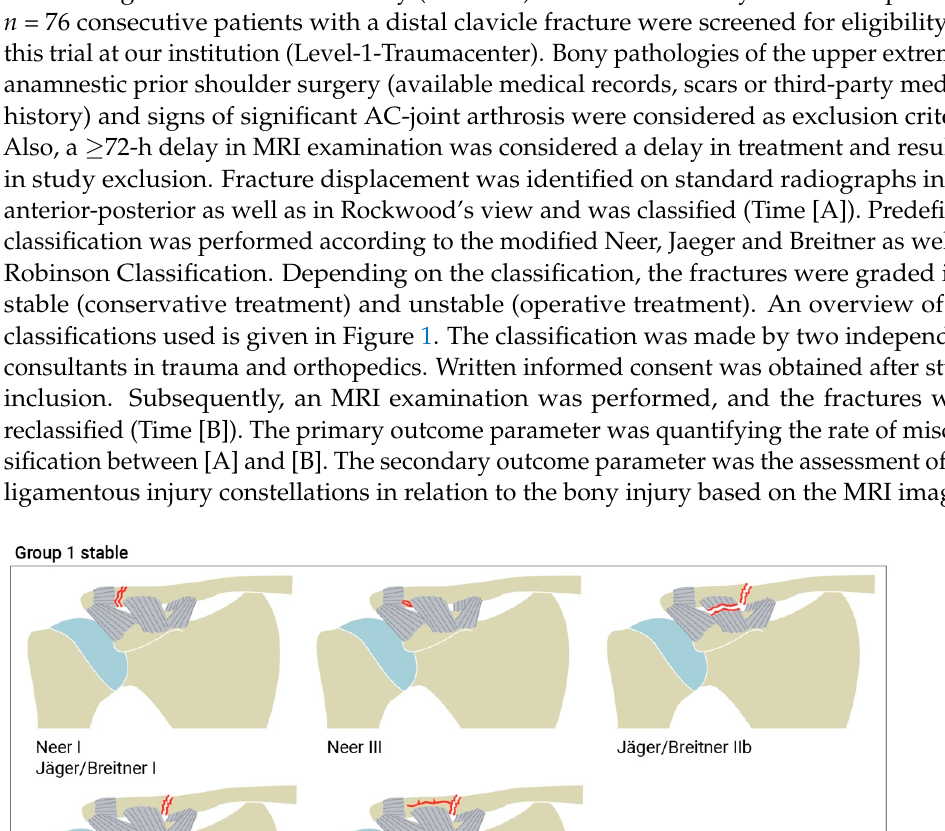
Figure 1. Overview of fracture classifications at the distal clavicle used in this study. The upper section of the graphic shows the stable fracture types and the lower part shows the unstable ones. 3. Results Of n = 76 patients presenting with a distal clavicle fracture at our hospital, n = 59 patients could be included. The reasons for non-inclusion were a lack of patient consent ( n = 6, 7.8%) or delayed availability of an MRI examination ( n = 11, 14.5%). No drop-out occurred after inclusion. The mean age was 38.7 ± 13.2 years, n = 12 (20.3%) patients were female. The distribution of fracture classifications at [A] and [B] is presented in Table 1. Table 1. Distribution of fracture classification at times A and B. Fracture Stability Classification